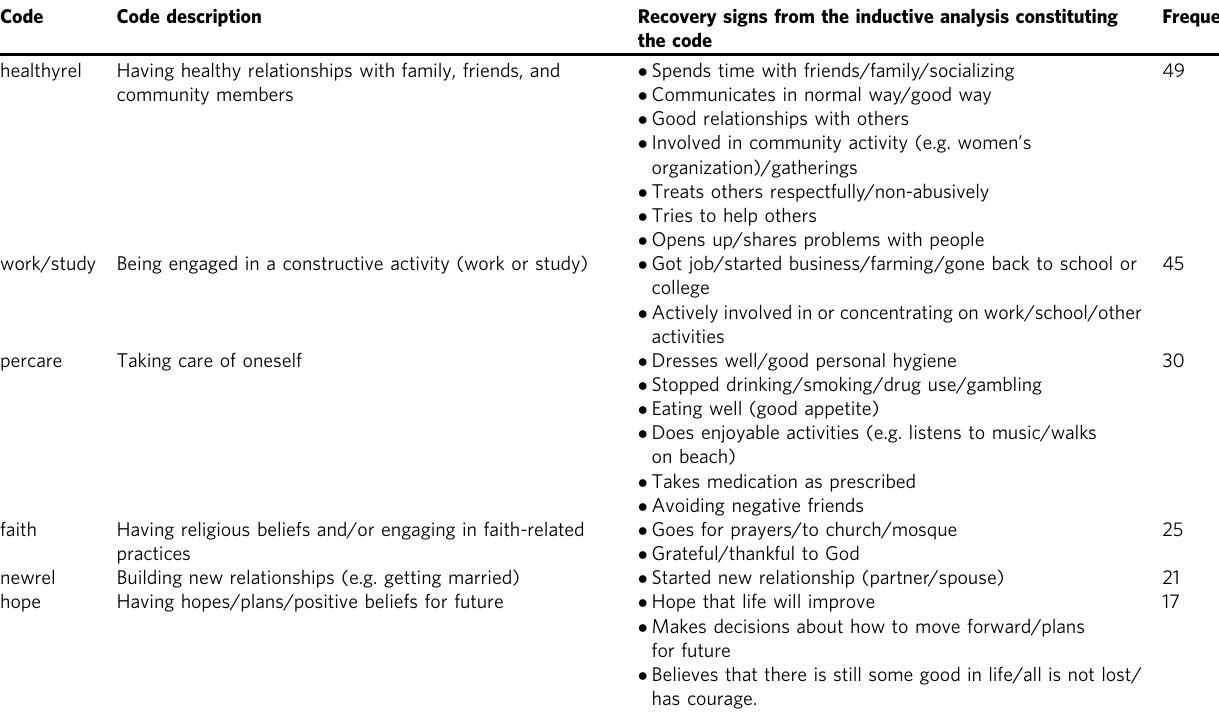
Table 4 Most frequent six signs of recovery used in QCA